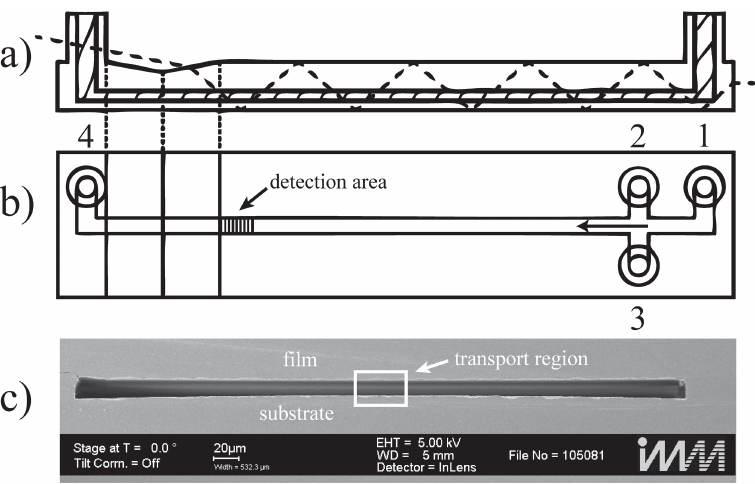
Figure 5. Microfluidic chip ( a ) Longitudinal cross section of the microfluidic chip. The shaded area is the microfluidic channel. The optical path of the excitation light is indicated using the dashed line entering in the upper left corner; ( b ) Channel top view. Port 1 is the connection for the sample syringe; ports 2 and 3 are the inlets for the sheath flow. The arrow in the channel shows the direction of flow. The shaded area indicates the detection area. Port 4 is the outlet; ( c ) Scanning electron microscope image of the channel cross section of the measurement channel. The highlighted rectangular frame indicates the transport region that contains the actual particles or cells. The wide regions to the left and right carry sheath liquid